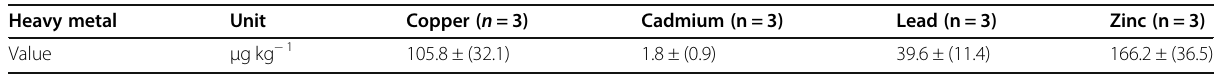
Table 6 Heavy metals analysis in ash Heavy